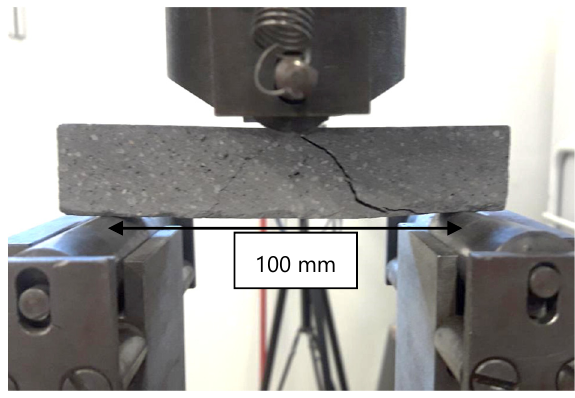
Figure 12. Three-point bend test on an MCF-reinforced specimen.